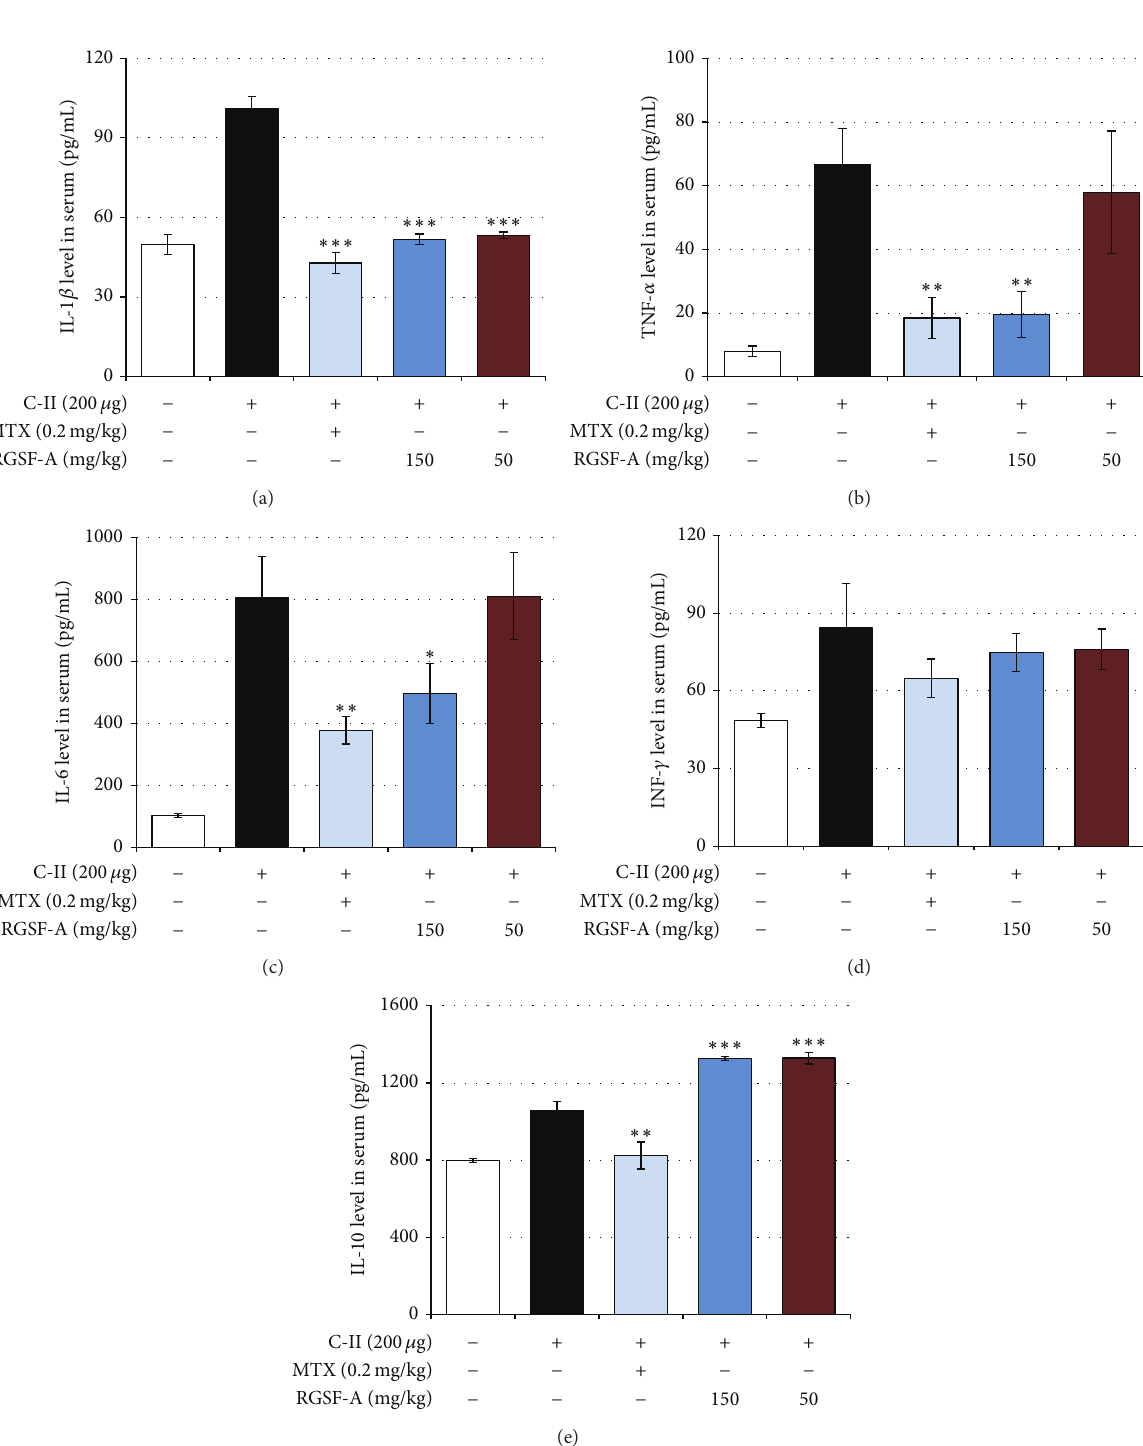
Figure 6: RGFS-A modifies serum levels of pro- and anti-inflammatory cytokines in CIA mice. CIA mice were treated with the indicated doses of RGSF-A, MTX, or vehicle. Blood was drawn by cardiac puncture from CIA mice at the end of the experiment and serum cytokine levels were measured by ELISA using protocols supplied by the manufacturer. Arthritis-induced IL-1 𝛽 (a), TNF- 𝛼 (b), IL-6 (c), INF- 𝛾 (d), and IL-10 (e) levels in the serum of CIA mice were analyzed. ∗ 𝑃 < 0.05 , ∗∗ 𝑃 < 0.01 , and ∗∗∗ 𝑃 < 0.001 versus vehicle control; 𝑛 = 6 for each